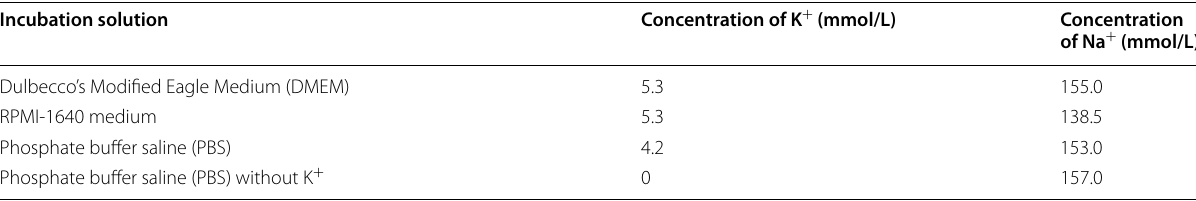
Table 2 Concentration of potassium and sodium in incubation solutions used in experiments